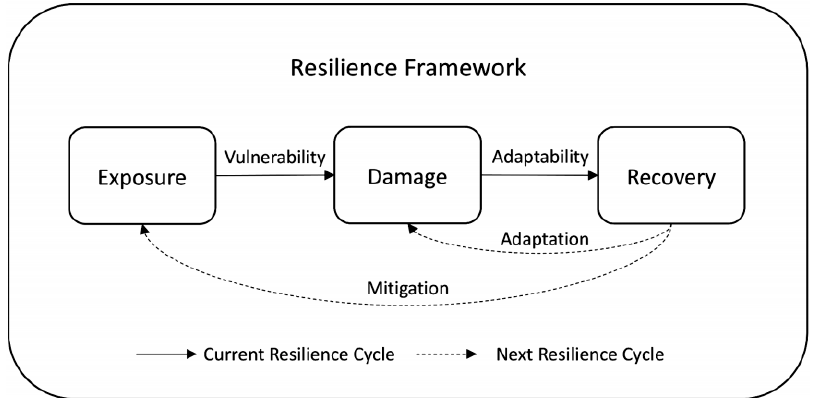
Figure 4. The Resilience Inference Measurement (RIM) model (with permission from ASCE) [20].